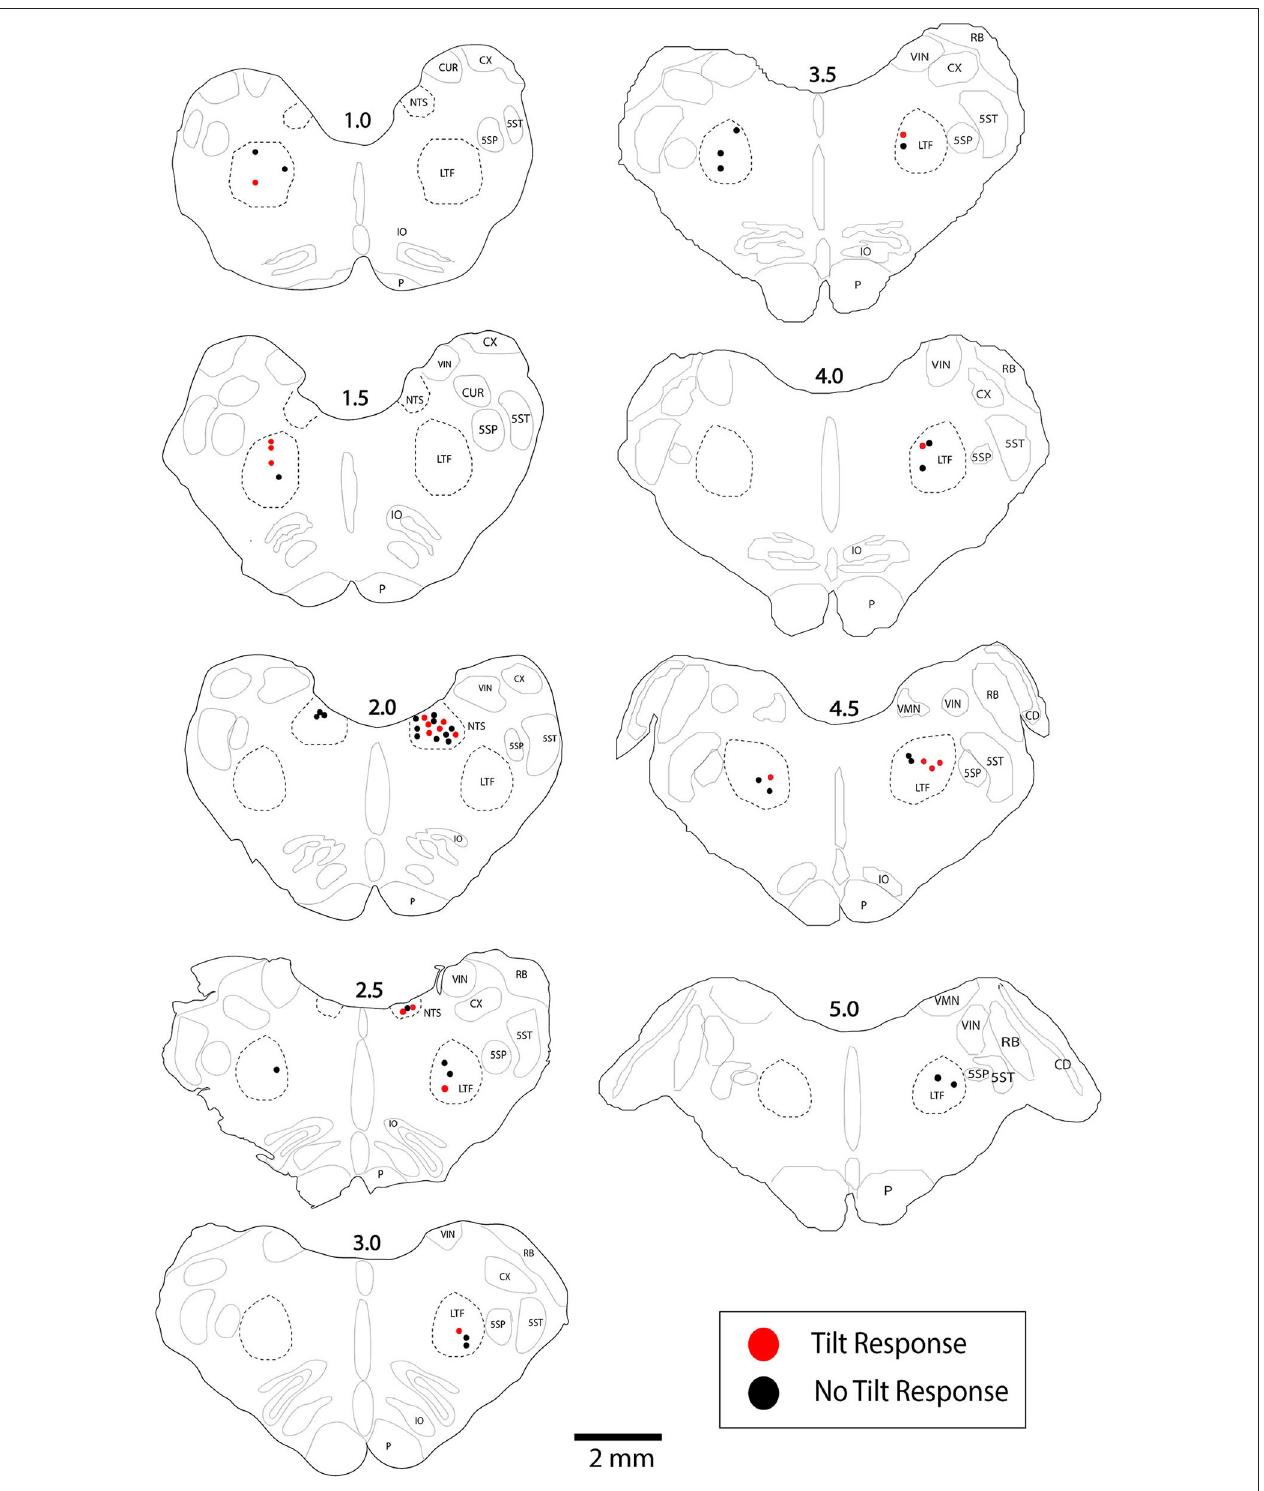
FIGURE 3 | Locations of LTF and NTS neurons with CRA whose responses to 40 ◦ tilts were recorded during five or more trials. Red symbols designate units with significant differences in unit activity in the nose-down and nose-up position. Black symbols designate units without significant responses to tilts. The numbers above each section indicate the distance rostral to the obex in mm. LTF, lateral tegmental field; NTS, nucleus tractus solitarius; 5SN, spinal trigeminal nucleus; 5ST, spinal trigeminal tract; CUR, cuneate nucleus, rostral; CX, external cuneate nucleus; IO, inferior olivary nucleus; P, pyramid; VIN, inferior vestibular nucleus; RB, restiform body; VMN, medial vestibular nucleus; CD, dorsal cochlear